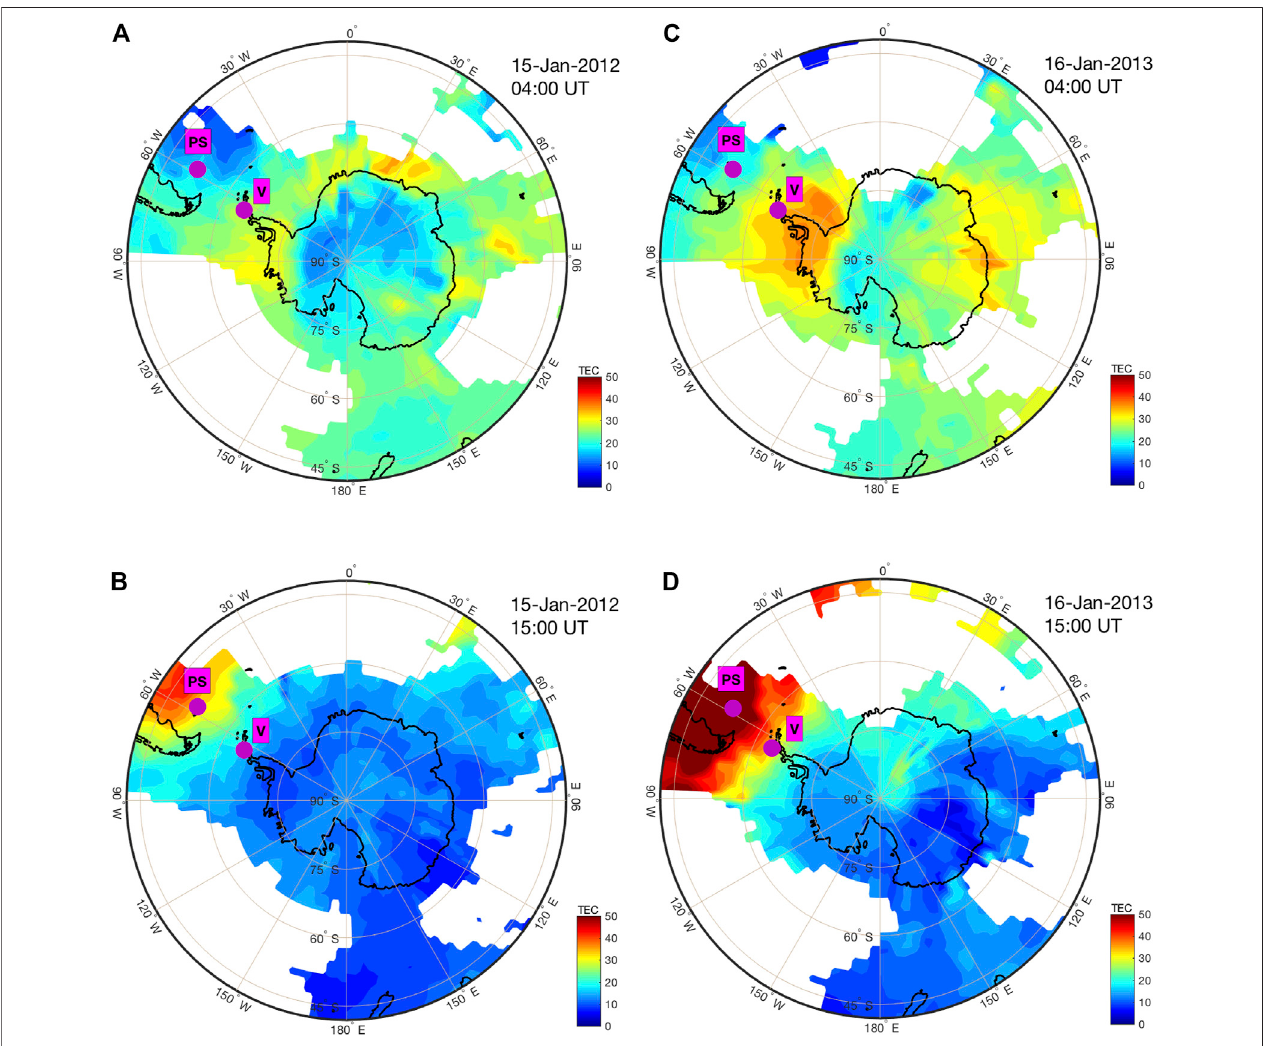
FIGURE 3 | Southern hemisphere polar maps showing TEC behavior during undisturbed Arctic conditions in January 2012 (left side, A, B ) and during an SSW in January 2013 (right side, C, D ). Top panels show snapshots at 4:00 UT and demonstrate increases in TEC over the entire Antarctic continent, with particularly large enhancement around the Antarctic Peninsula (30 – 120 ° W). Bottom panels (snapshots at 15:00 UT) demonstrate a strong increase in TEC from ∼ 60 ° E to 120 ° W, with largest increases in the American longitudinal sector. Magenta dots indicate the locations of the Port Stanley and Vernadsky ionosondes stations.